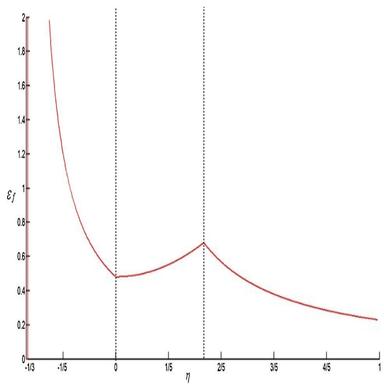
Equivalent plastic damage strain versus stress triaxiality.